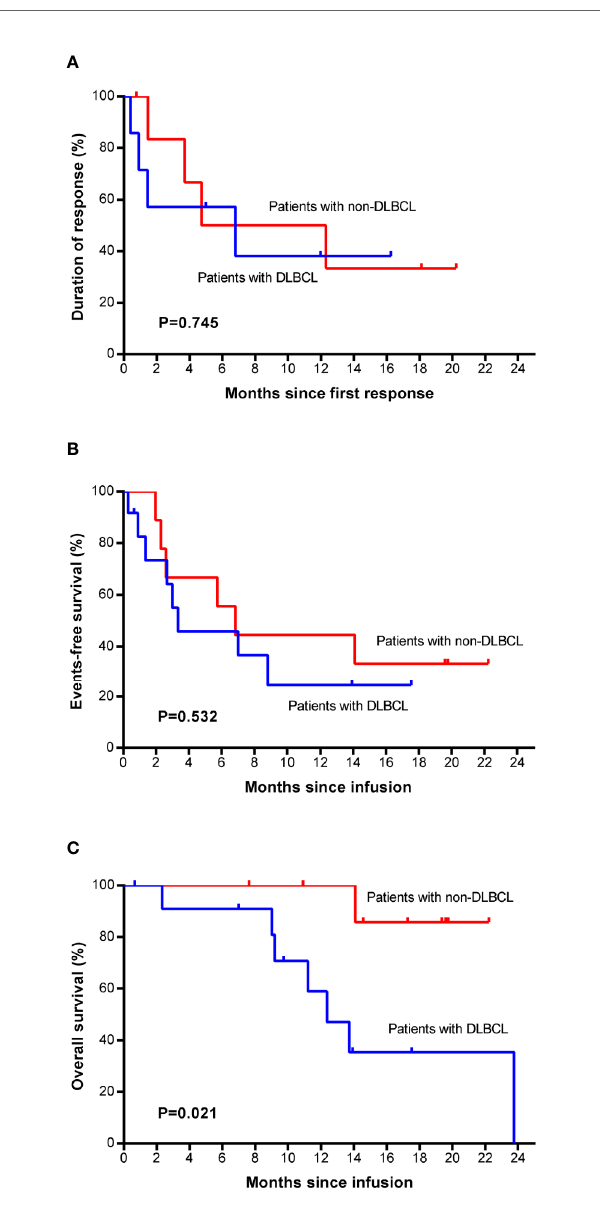
FIGURE 5 | Survival comparison between patients with DLBCL and with non- DLBCL. Duration of response (A) , event-free survival (B) , and overall survival (C) between the two groups. Non-DLBCL, patients with non-Hodgkin ’ s lymphomas other than DLBCL. DLBCL, diffuse large B cell